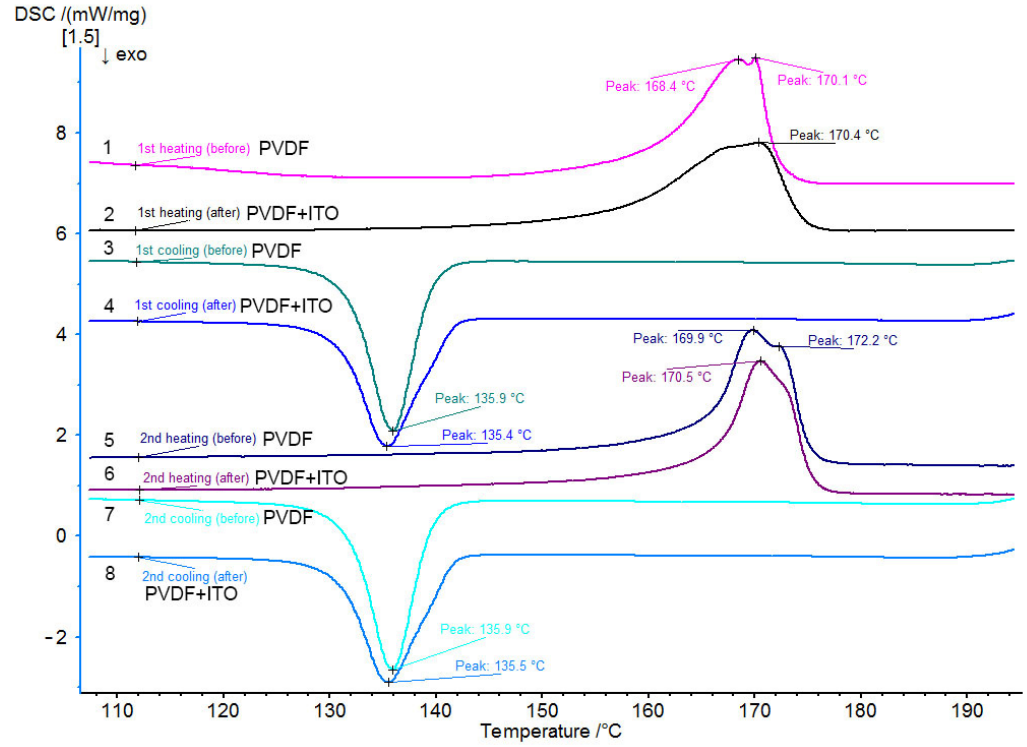
Figure 2. DSC curves for the original PVDF films without ITO (curves 1, 3, 5, 7) and with ITO (curves 2, 4, 6, 8).